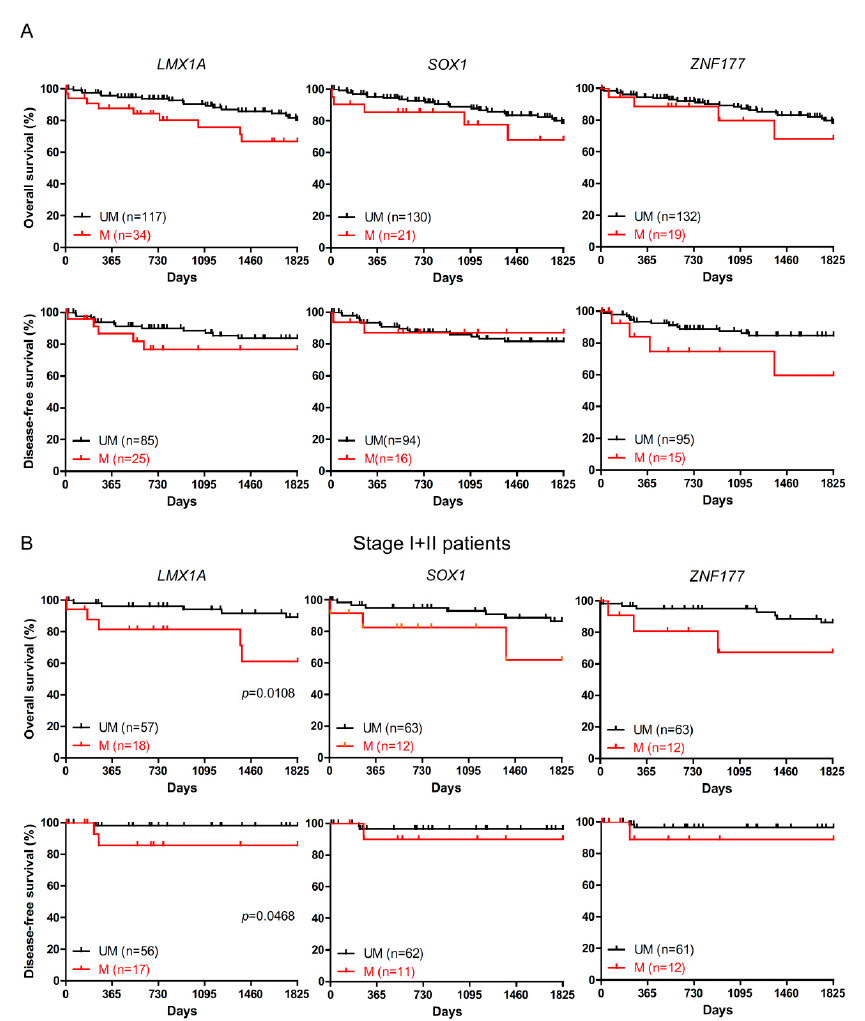
Figure 2. Correlation analysis between LMX1A , SOX1 , and ZNF177 methylation levels and survival in CRC patients. ( A ) The 5-year overall survival and disease-free survival rates of CRC patients with different LMX1A , SOX1 , and ZNF177 methylation statuses are presented. Red lines indicate cases with LMX1A methylation (methylation index (MI) > 16.84), SOX1 methylation (MI > 30.26), and ZNF177 methylation (MI > 51.14). Black lines indicate cases without LMX1A methylation (MI ≤ 16.84), SOX1 methylation (MI ≤ 30.26), and ZNF177 methylation (MI ≤ 51.14). ( B ) The 5-year overall survival and disease-free survival rates of stage I and II CRC patients.